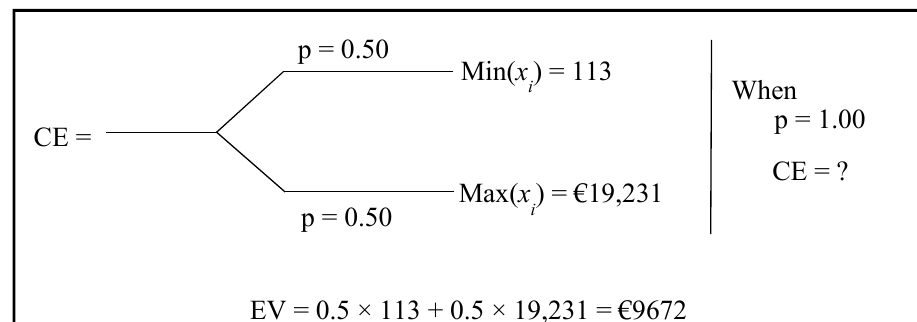
Figure 8. Lottery setup to discern utility values for annual maintenance cost.